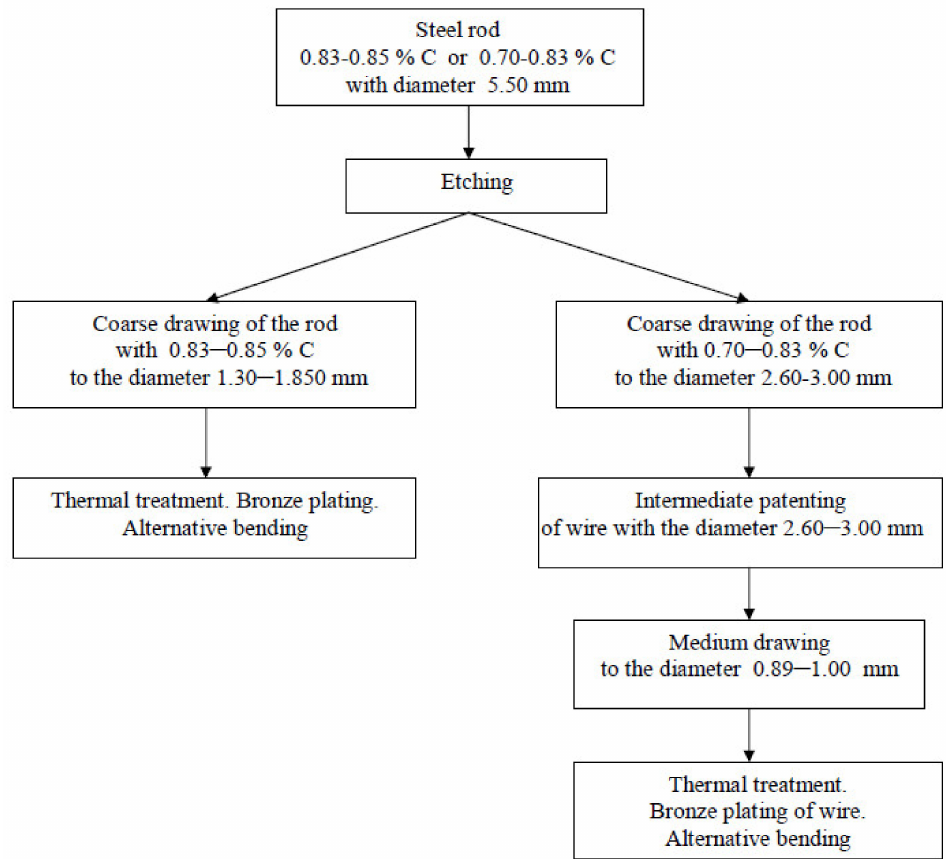
Figure 6. Technological scheme for the manufacture of bronzed, high-carbon steel wire with high strength.